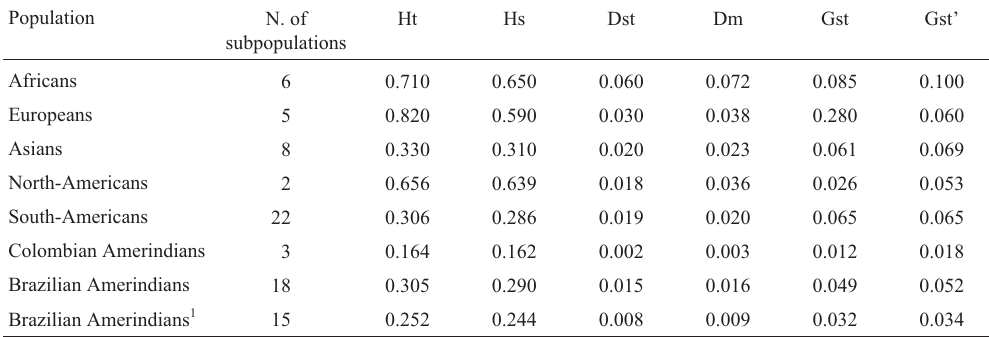
Table 2 - β -globin gene haplotype diversity in American natives and other human populations. Population N. of